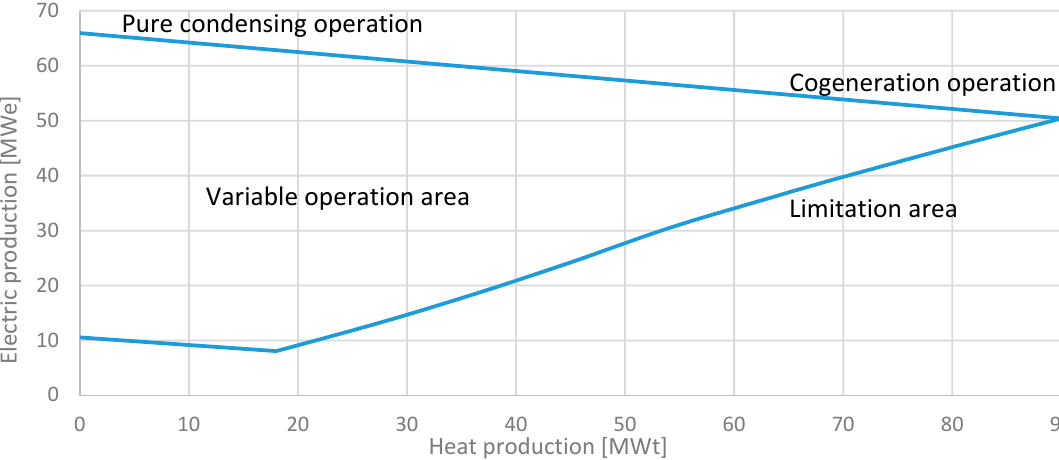
Figure 4. Dependence between electrical and heat production for the bigger CT in the CPP [5].